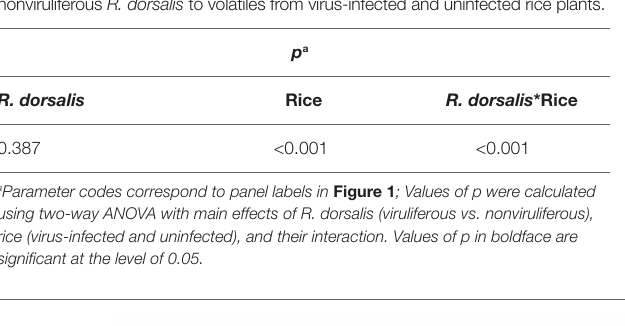
TABLE 2 | Statistical analysis of selective responses of viruliferous and nonviruliferous R. dorsalis to volatiles from virus-infected and uninfected rice